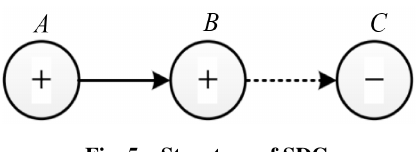
Fig. 5 Structure of